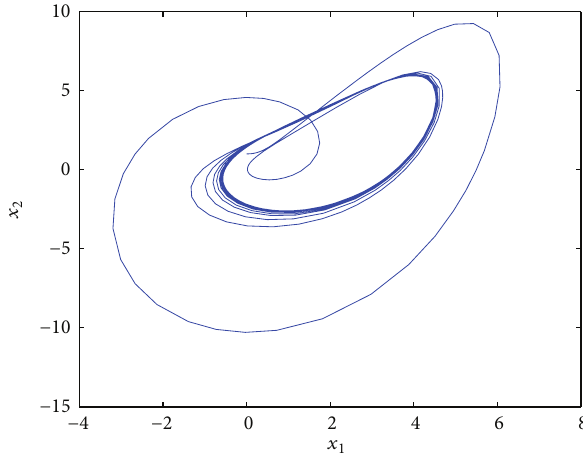
Figure 8: Periodic trajectories in 𝑥 1 − 𝑥 2 plane (𝑢 = 3.5) .